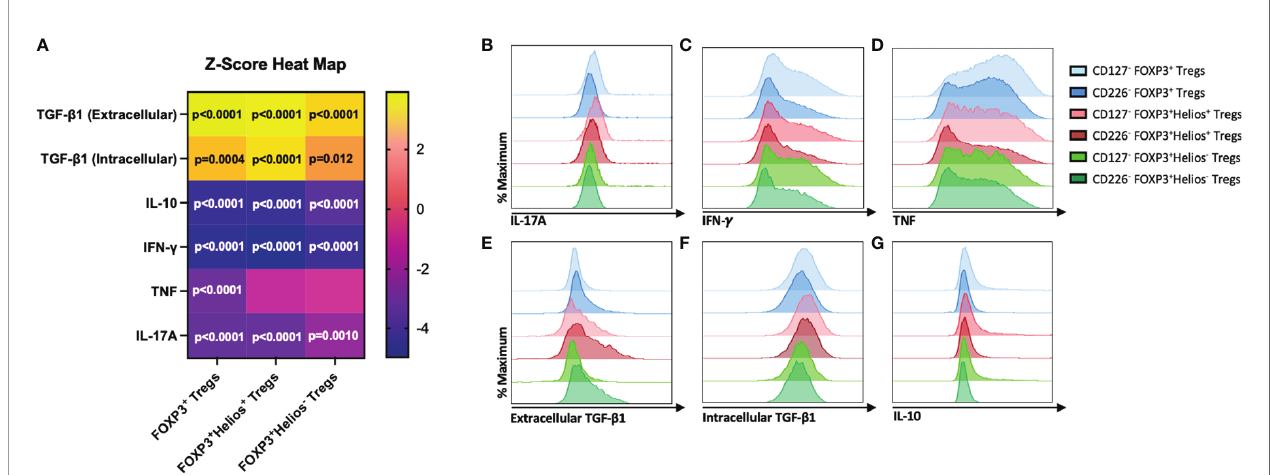
FIGURE 5 | CD226 - Tregs exhibit a less in fl ammatory cytokine pro fi le than CD127 lo/- Tregs. Cytokine production by 14-day ex vivo expanded CD127 lo/- sorted Treg and CD226 - sorted Treg cultures was examined by fl ow cytometry following a four-hour PMA/Ionomycin stimulation in the presence of a protein transport inhibitor. (A) Heat map shows the mean fold change of protein expression (z-score) of cytokines (rows) by CD226 - FOXP3 + , FOXP3 + Helios + , and FOXP3 + Helios - Treg populations (columns) compared to CD127 lo/- Treg populations. n = 9 biological with n = 2 technical replicates. Signi fi cant P-values are reported on the fi gure for two-way ANOVA with Bonferroni ’ s multiple comparisons between Treg isolation conditions of matched subjects. Representative histograms show expression of (B) IL-17A, (C) IFN- g , (D) TNF, (E) Extracellular TGF- b 1, (F) Intracellular TGF- b 1, and (G) IL-10 for CD127 lo/- (lighter blue) and CD226 - CD4 + CD25 + FOXP3 + Tregs (darker blue), CD127 lo/- (lighter red) and CD226 - CD4 + CD25 + FOXP3 + Helios + Tregs (darker red), and CD127 lo/- (lighter green) and CD226 - CD4 + CD25 + FOXP3 + Helios - Tregs (darker